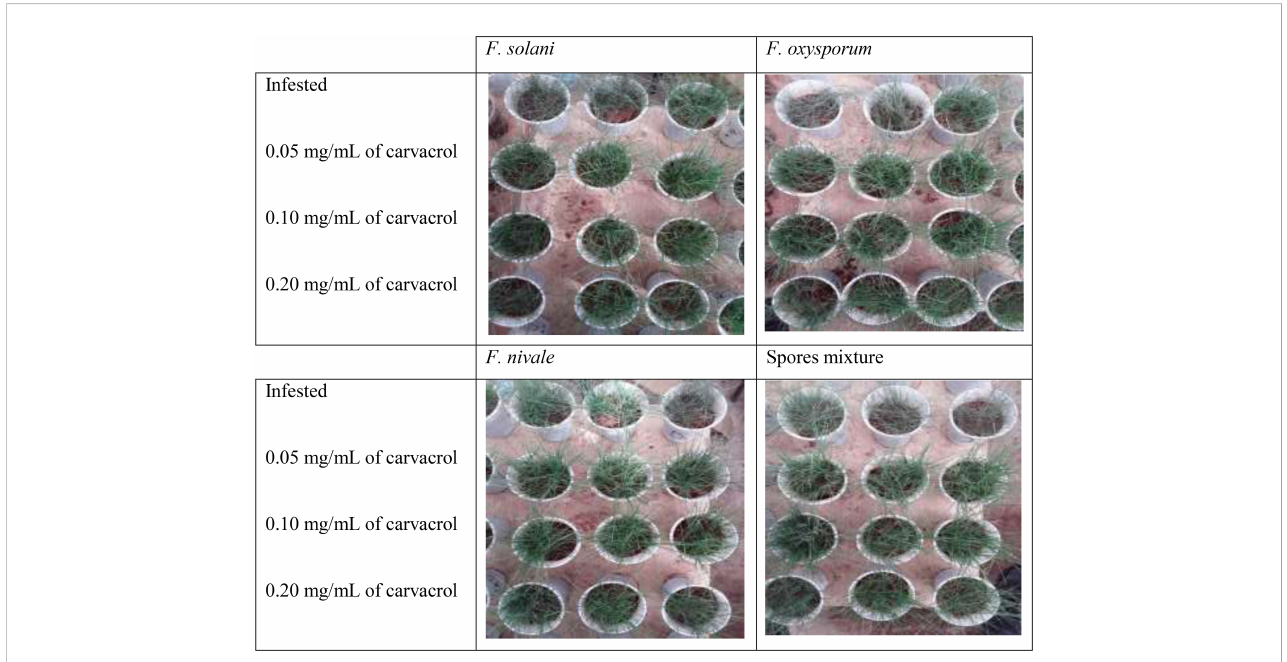
FIGURE 5 The visual appearance of the health status of ryegrass in normal soil after 4 weeks of preventive treatment with carvacrol under greenhouse